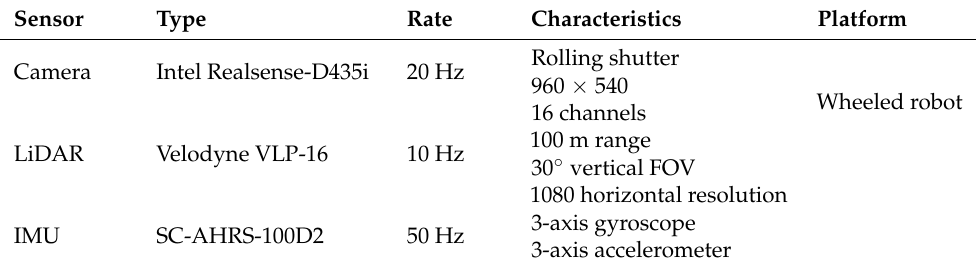
Figure 7. The wheeled robot is equipped with an upward-looking camera for collecting ceiling images and other sensors, such as LiDAR and IMU. Table 1. Overview of the sensors in our wheeled robot platform.